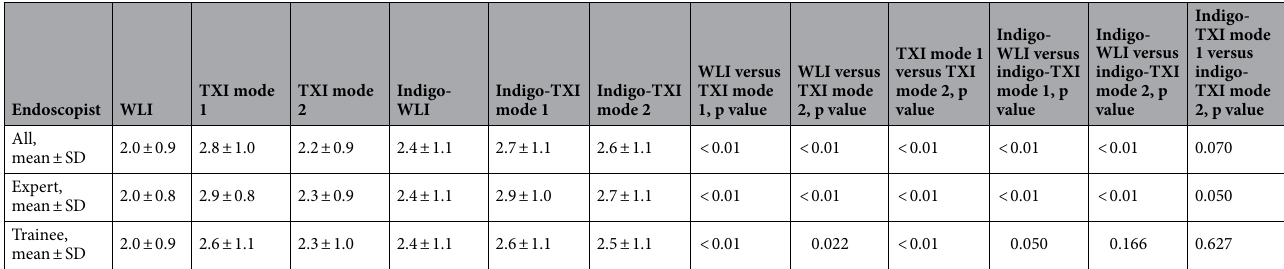
Table 2. Mean visibility scores of the gastric neoplasms imaged using WLI, TXI mode 1, TXI mode 2 indigo- WLI, indigo-TXI mode 1, and indigo-TXI mode 2. WLI white-light imaging, TXI mode 1 Texture and Color